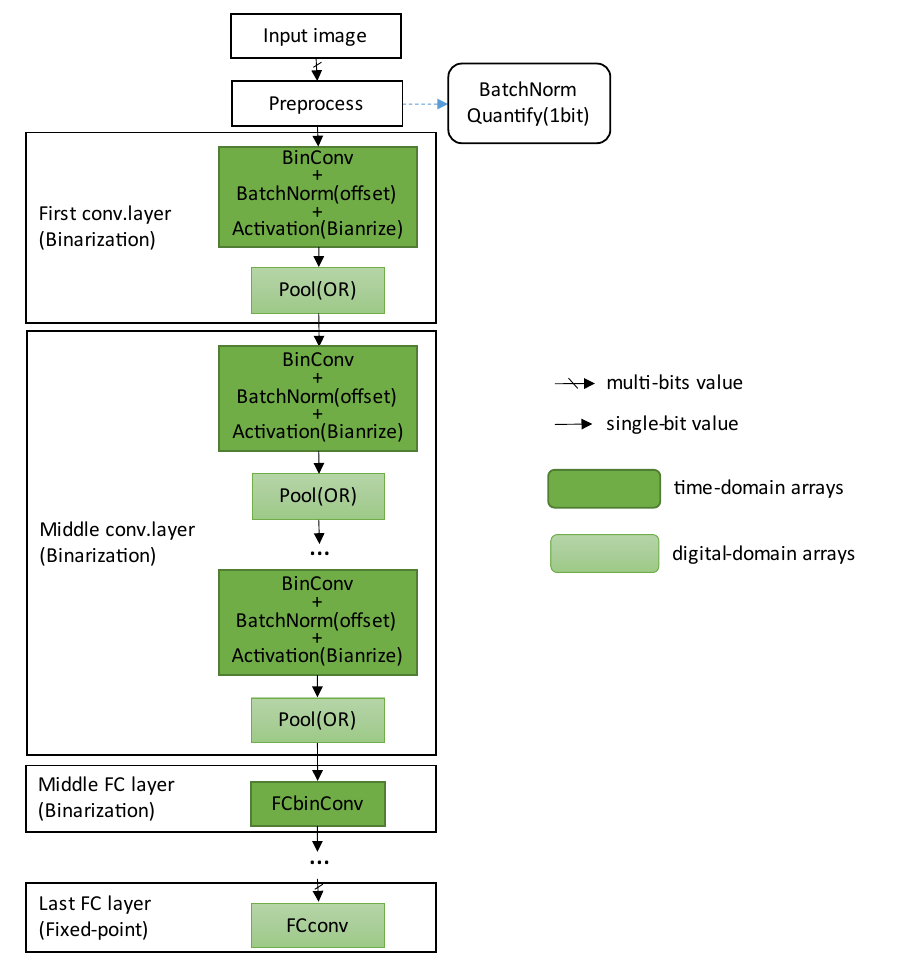
Figure 7. Full-BNN model based on time domain.